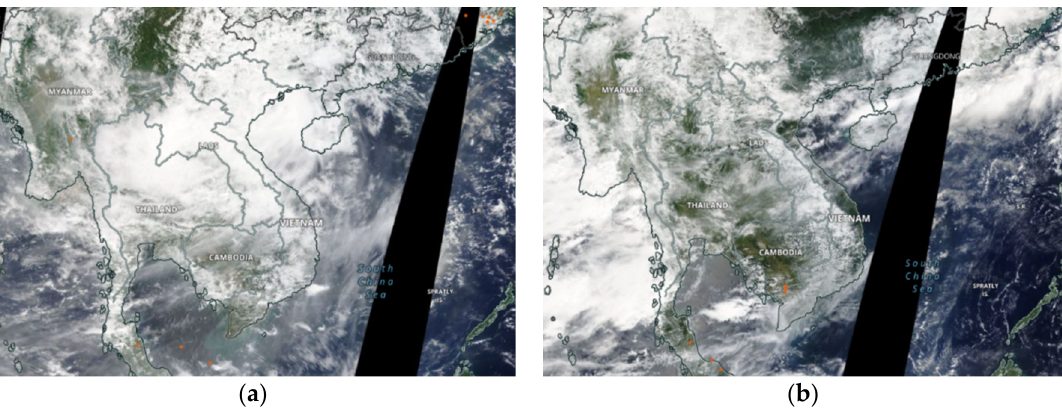
Figure 6. Satellite imagery for biomass burning, obtained from the NASA Worldview application (http://worldview. earthdata.nasa.gov/ (accessed on 20 November 2020)), and fire spots from Terra over ( a ) 17 August 2016 to 20 August 2016 ( left ); and ( b ) 2 September 2016 to 5 September 2016 ( right